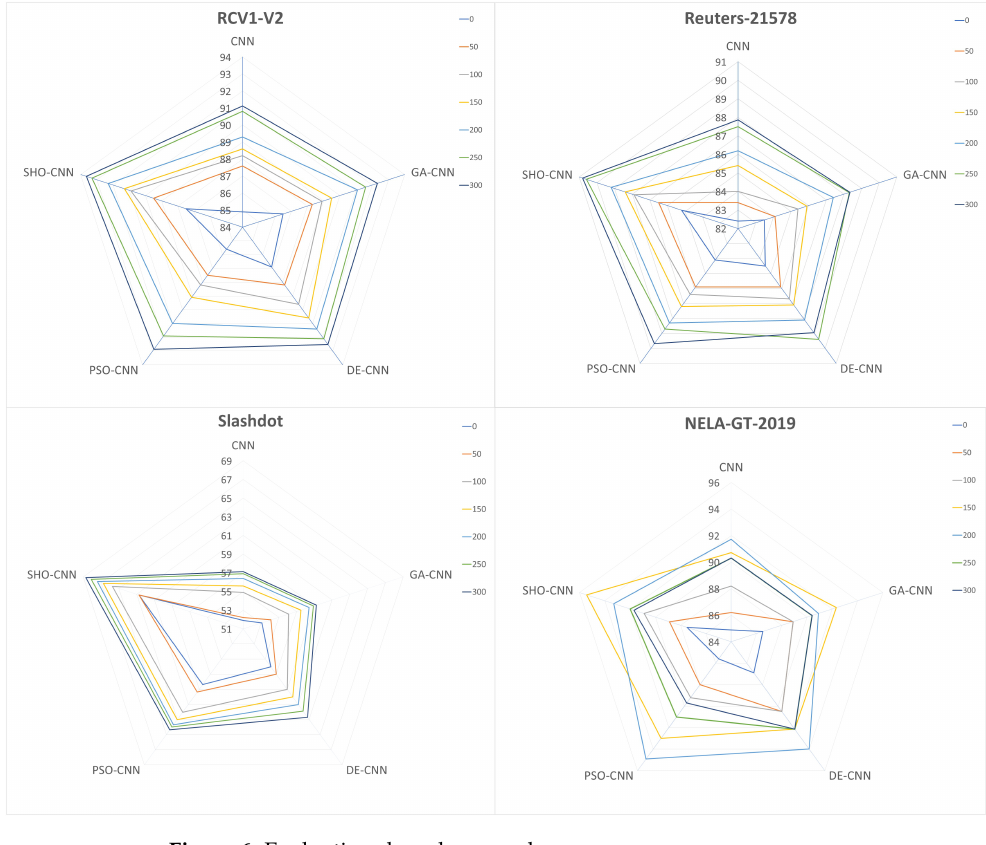
Figure 6. Evaluations based on epochs.